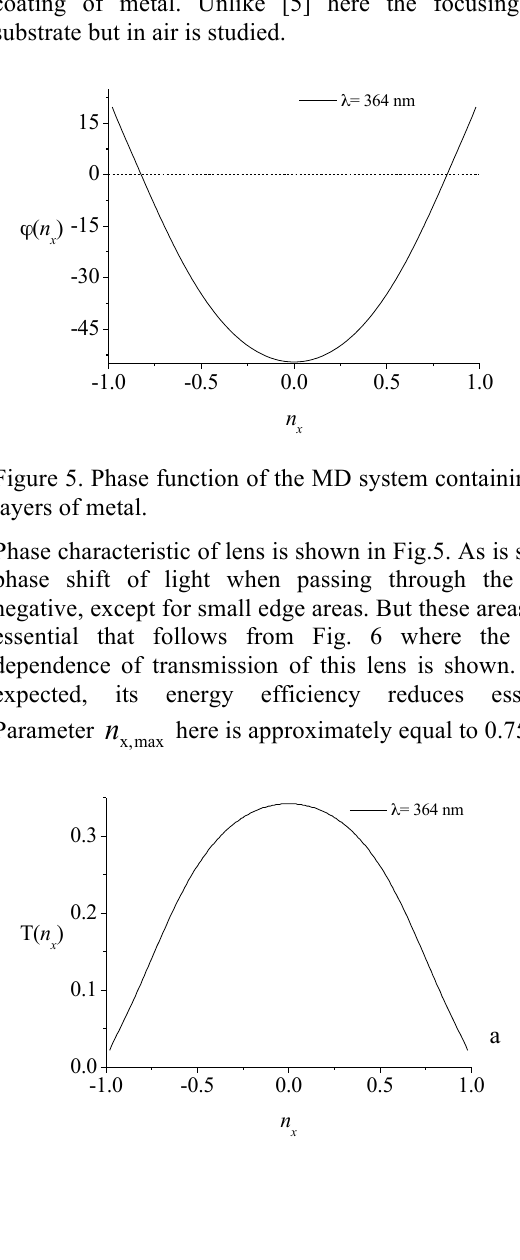
Figure 6. Transmission function of flat lens (a). Dependence z (z ) providing the minimum of phase distortion. 2 1 Wavelength λ is equal to 364